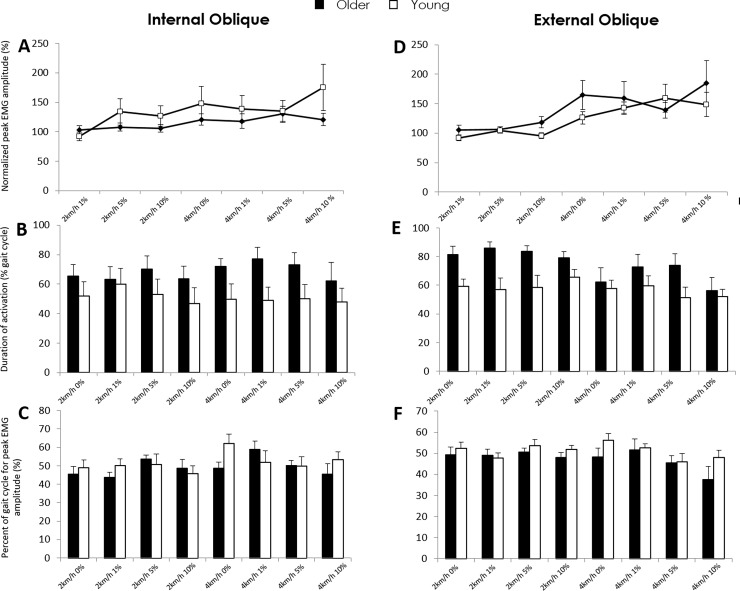
Surface EMG (means with SDs) in young and older adults for internal (left) and external (right) obliques during treadmill-walking under various speed-inclination conditions. A&D, Normalised (to 2km/h-0%) peak amplitude; B&E, Duration of activation as percent of the gait cycle; and C&F, Percentage of the gait cycle where peak amplitude occurred.